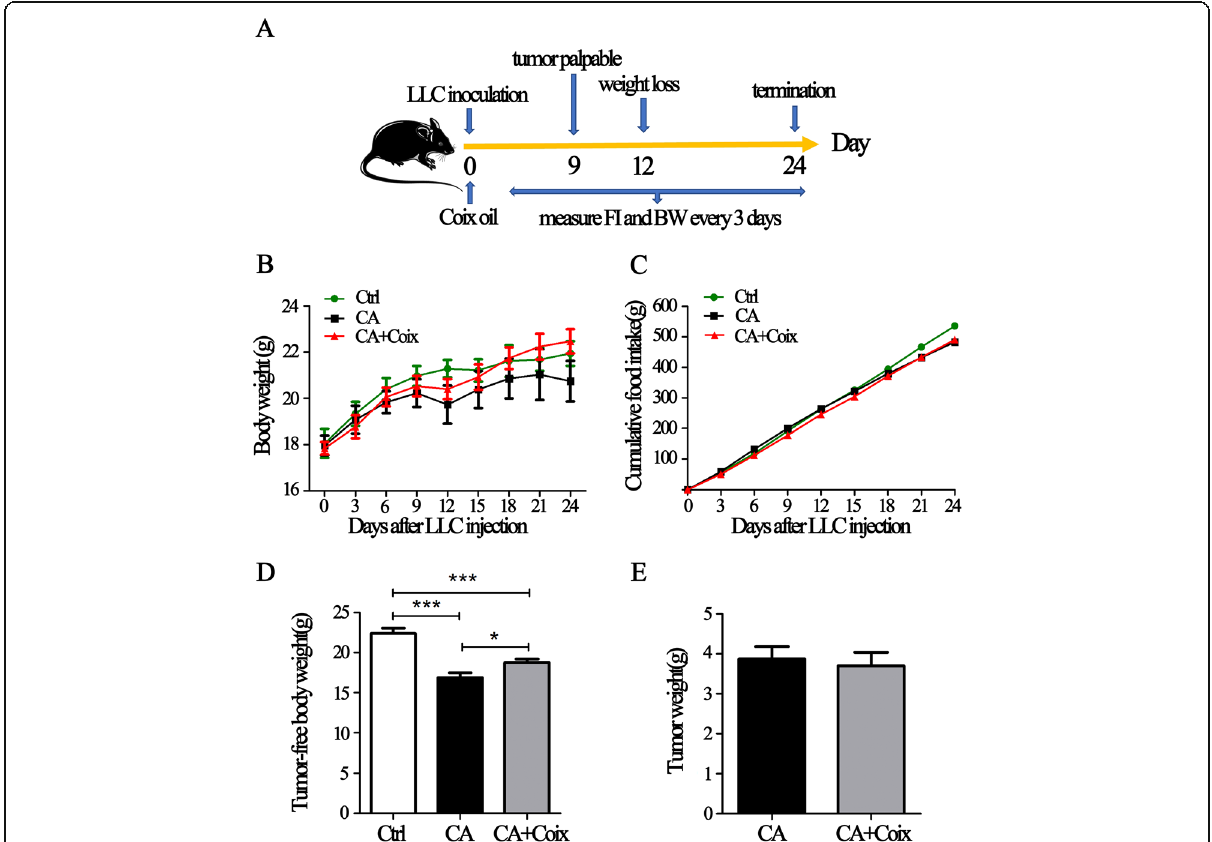
Fig. 1 CSO prevented body weight loss of LLC-bearing mice. a . The whole work flow of the animal experiment. b .The average body weights of the mice in three groups (Ctrl, CA, CA + Coix) were measured every 3 days. c . Changes of cumulative food intake combined of all seven mice in each group were recorded over the whole experiment. d, e .The tumor-free body weight (D) and tumor weight (E) were measured after mice were sacrificed. Values were expressed as mean ± SEM (* P <0.05, *** P